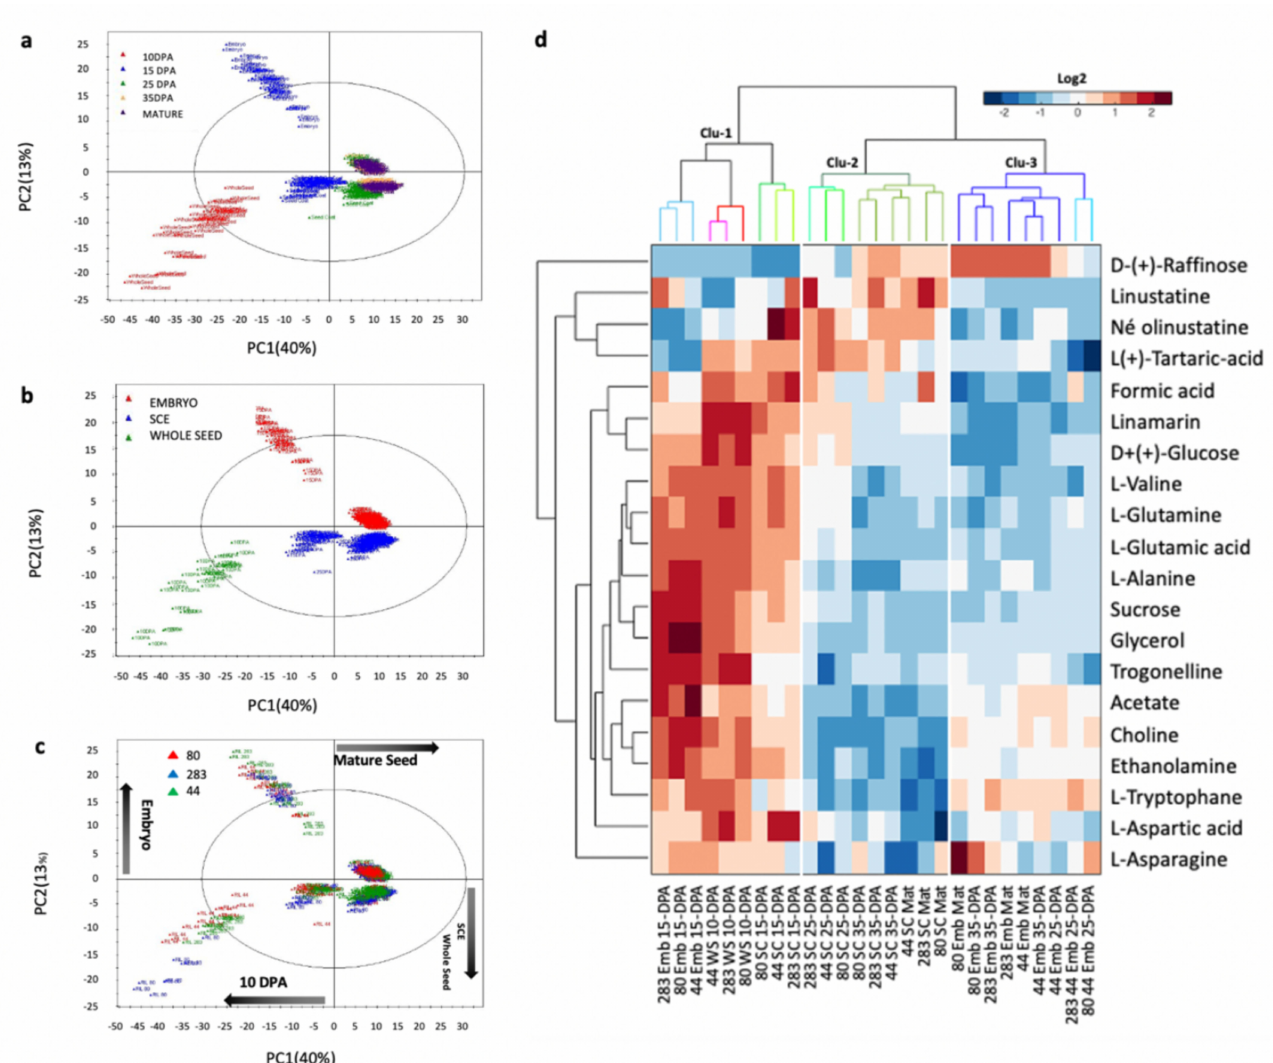
Figure 2. Metabolite profiling in flax RILs during seed development. ( a – c ) PCA scores plot of the 1H-NMR experiment performed on the three selected RILs during seed development and according to the specific tissues analyzed. PCAs are labelled according to the developmental stages following the horizontal component ( a ), tissues following the vertical component ( b ) or the selected RILs ( c ). ( d ) HCA of the discriminant metabolites identified from metabolite profiling according to the 27 different experimental conditions. The color scale represents mean intensities (Log2 transformed) of the relative metabolite content. Data are means of 10 to 18 biological replicates. The dendrogram color code illustrates hierarchical clustering according to the tissues (10 DPA Whole seed, red; Embryo, blue; seed coat/endosperm (SCE), green). Clu,